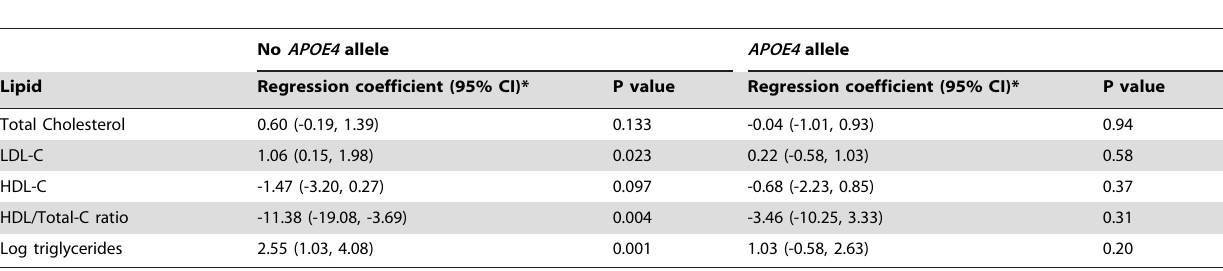
Table 4. Associations between BMI and blood lipids in the low fitness group by absence (n=104) or presence (n=41) of an APOE4